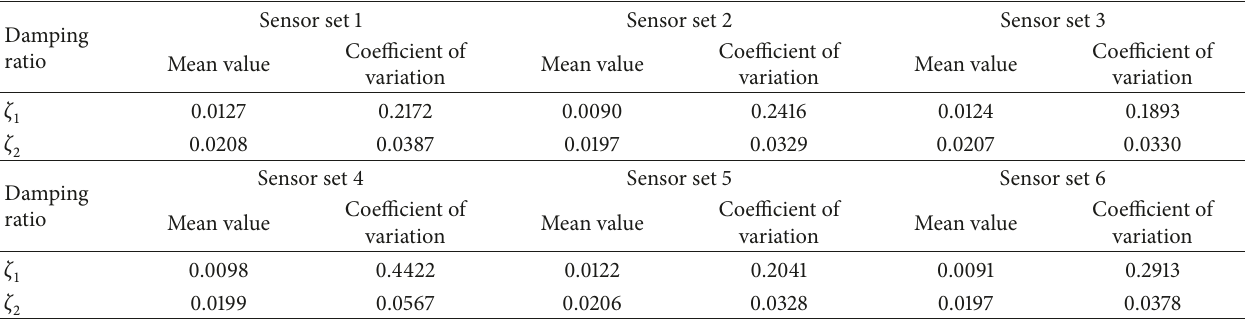
Table 7: Identification results with conventional